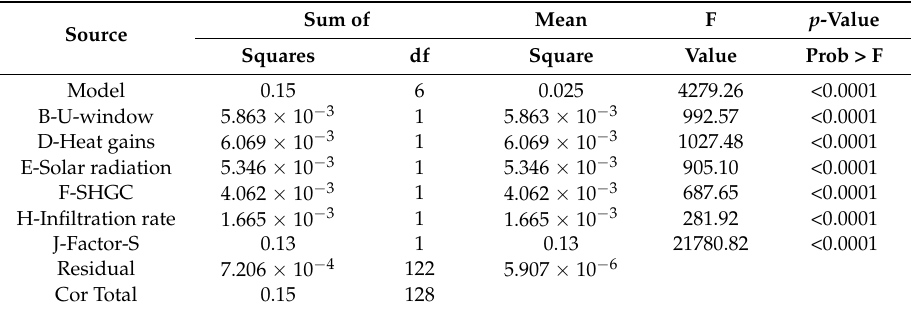
Table 9. Analysis of variance (ANOVA) for selected model for optimum U*.